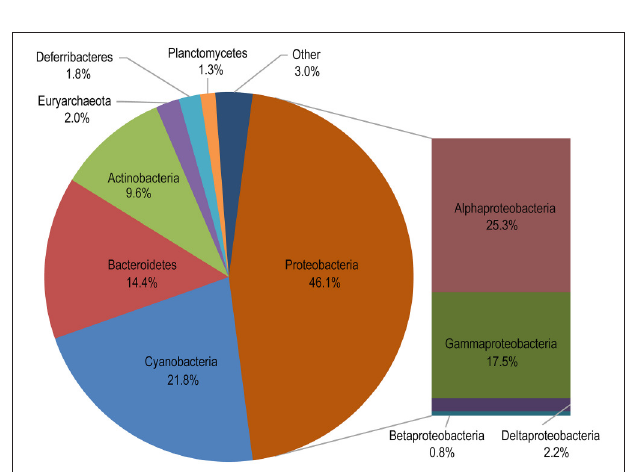
FIGURE 4 | Taxonomic distribution of all assigned reads. “Other” comprises taxa accounting for < 1% of the total quality